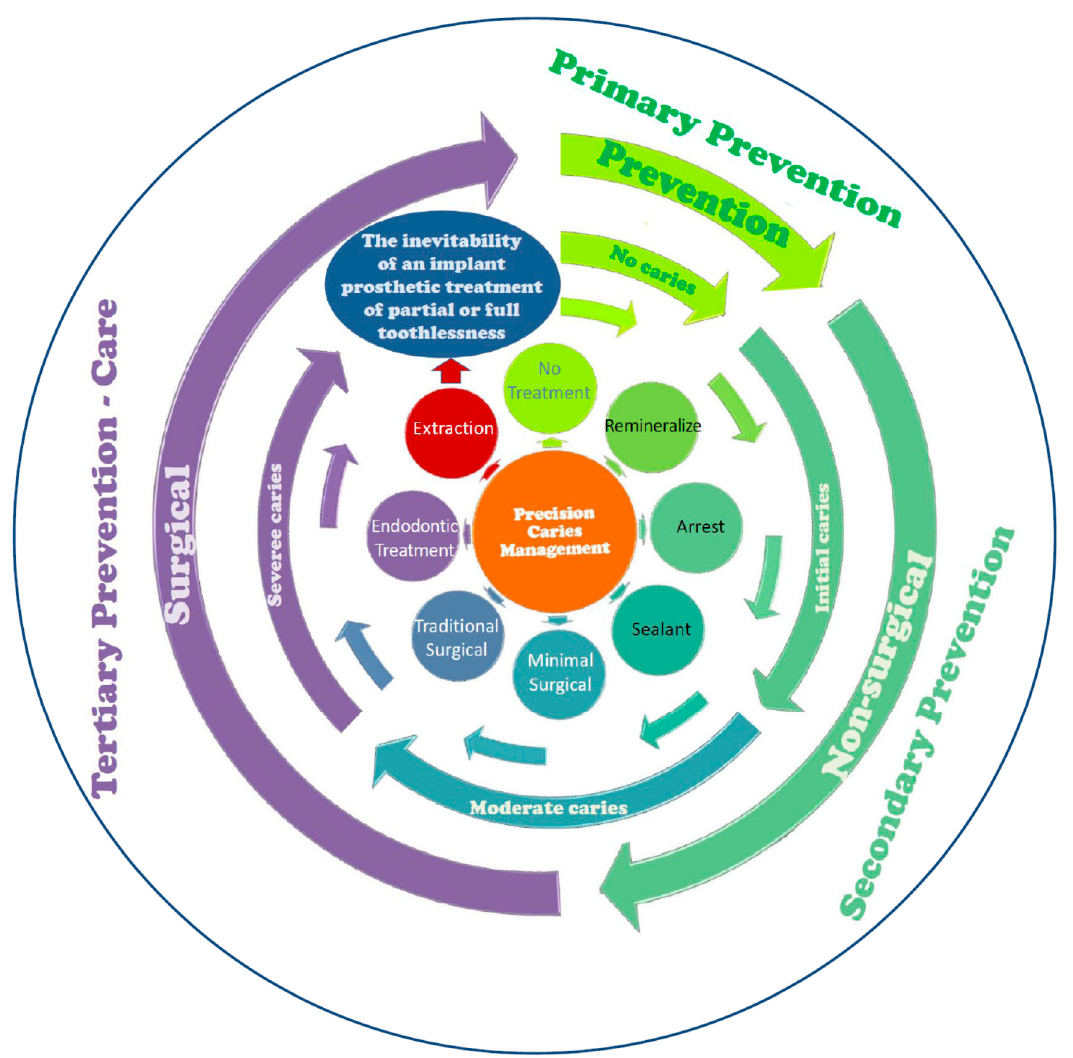
Figure 11. Precision Caries Management (PCM) schematic diagram developed in the form of the complex developed concentric circles by analogy to the Deming circle with a wide range of possible therapeutic decisions depending on the stage of caries development.